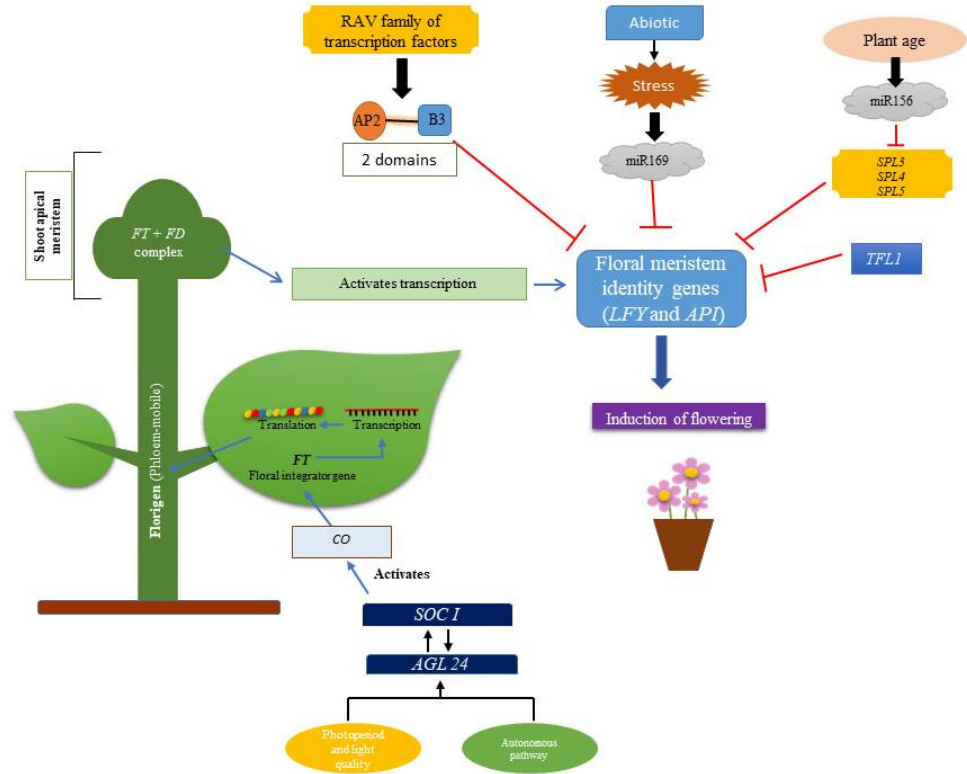
Figure 2. Various genes involved in regulation of flowering in plants [ RAV , R elated transcription factors to AP1 and VP1 ; stress and age induced microRNAs formed (miRNA169 and miRNA156, respectively) are involved in transcription repression of floral meristem identity genes; i.e., LFY and AP1 genes whereas Agamous like 24 (MADS box transcription factor) interacts with SOC1 (Suppressor of overexpression of CONSTANS ) and activates CO1 ( CONSTANS1 ) gene resulting in activation of Floral integrator gene, FT , which interacts with bZIP transcription factor, FD , hence, expressing floral meristem identity genes resulting in flowering].